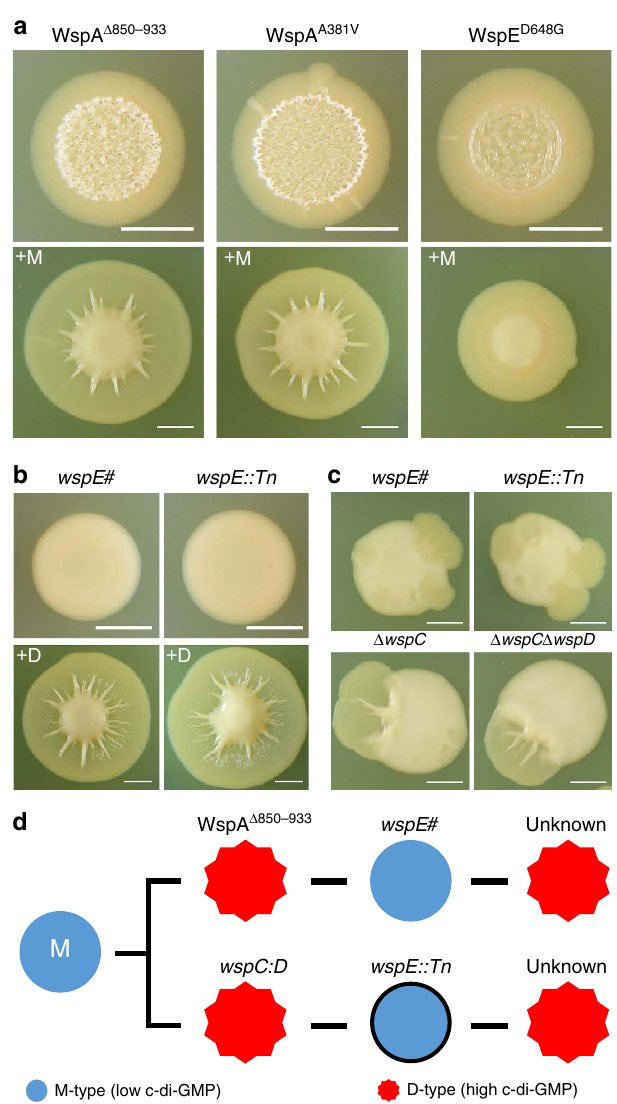
Figure 7 | Multiple D genotypes evolve and bidirectional evolution generates M from D and vice versa. ( a ) Phenotypes of additional D morphotypes individually isolated from a single spreading fan emerging from discrete M colonies (day 3, top). Each variant reproduces the spreading phenotype when mixed with M (day 8, bottom). ( b ) Mucoid colony morphology of the wspE # and wspE::Tn revertants (day 3) and their spreading phenotype when mixed with D (day 8). ( c ) Emergence of spreading fans from various mutants captured on day 9. Each starting strain harbours a mutation predicted to terminally shut down the Wsp signalling pathway, suggesting that additional c-di-GMP production pathways are involved in the transitions between the M and D morphotypes. ( d ) Summary of the bidirectional evolution of M and D morphotypes. All strains of the D morphotype exhibit reduced motility, indicative of reduction in c-di-GMP production. All mutations were naturally selected with the exception of wspE::Tn (black outline). All mixed colonies were initiated at a 1:1 ratio. Scale bars,